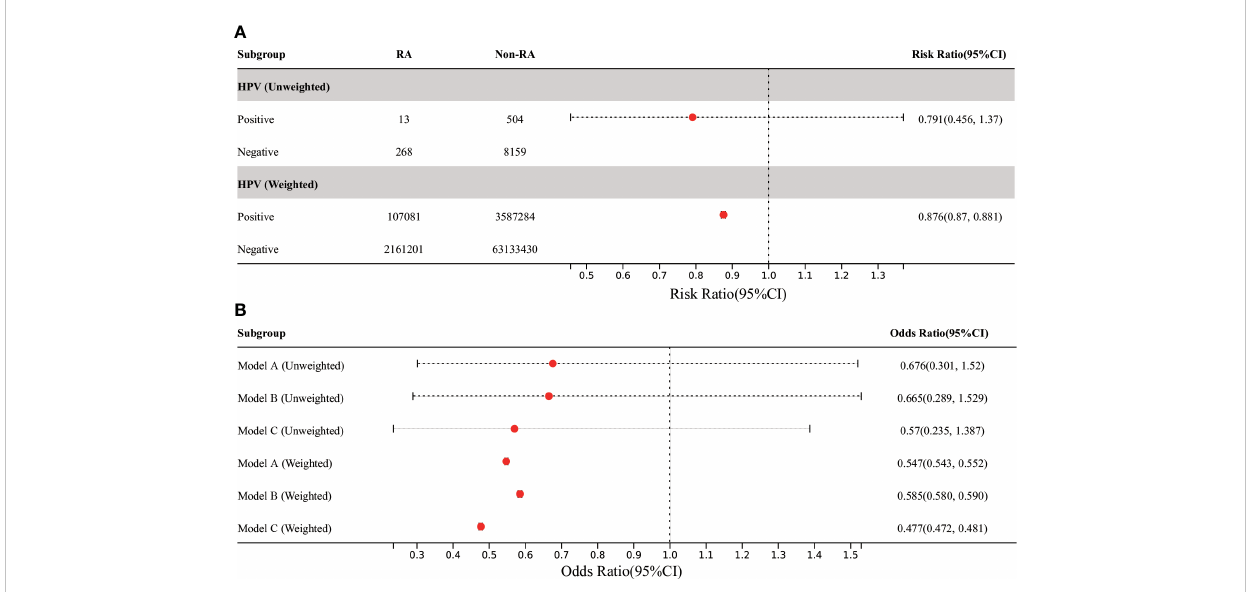
FIGURE 5 Association between HPV immunization and RA in US adults. (A) Among all participants, the prevalence of RA in adults was signi fi cantly decreased in the HPV-vaccinated group compared with the HPV-unvaccinated control group. (B) In the three MLR models, the adjusted OR value of HPV immunization and RA in American adults aged 18-59 was signi fi cantly decreased, but it was only statistically signi fi cant in weighted models. Model A was only adjusted for age and gender. Model B was adjusted for the confounding covariates with the numerical missing ratio below 5%. Model C was further adjusted for all confounding covariates. HPV, Human papillomavirus; BMI, body mass index; DM, diabetes mellitus; MLR, multivariate logistic